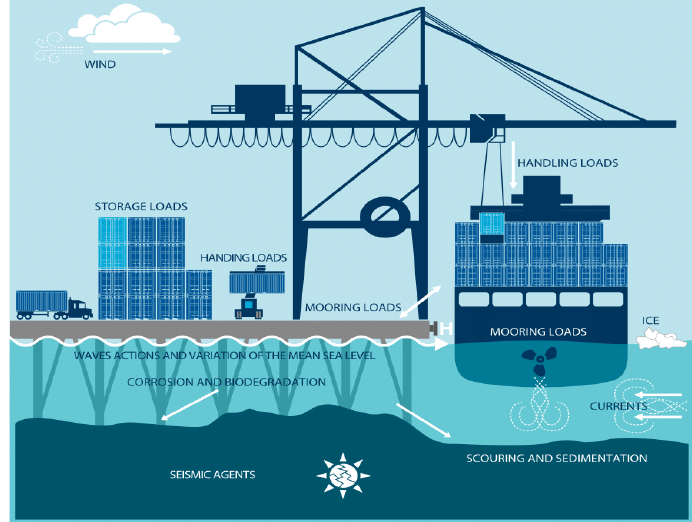
Figure 1. General scheme of the predominant forcing agents interacting with a berthed ship and the terminal elements. Reproduced from Gómez and Molina et al. (2018) [3].